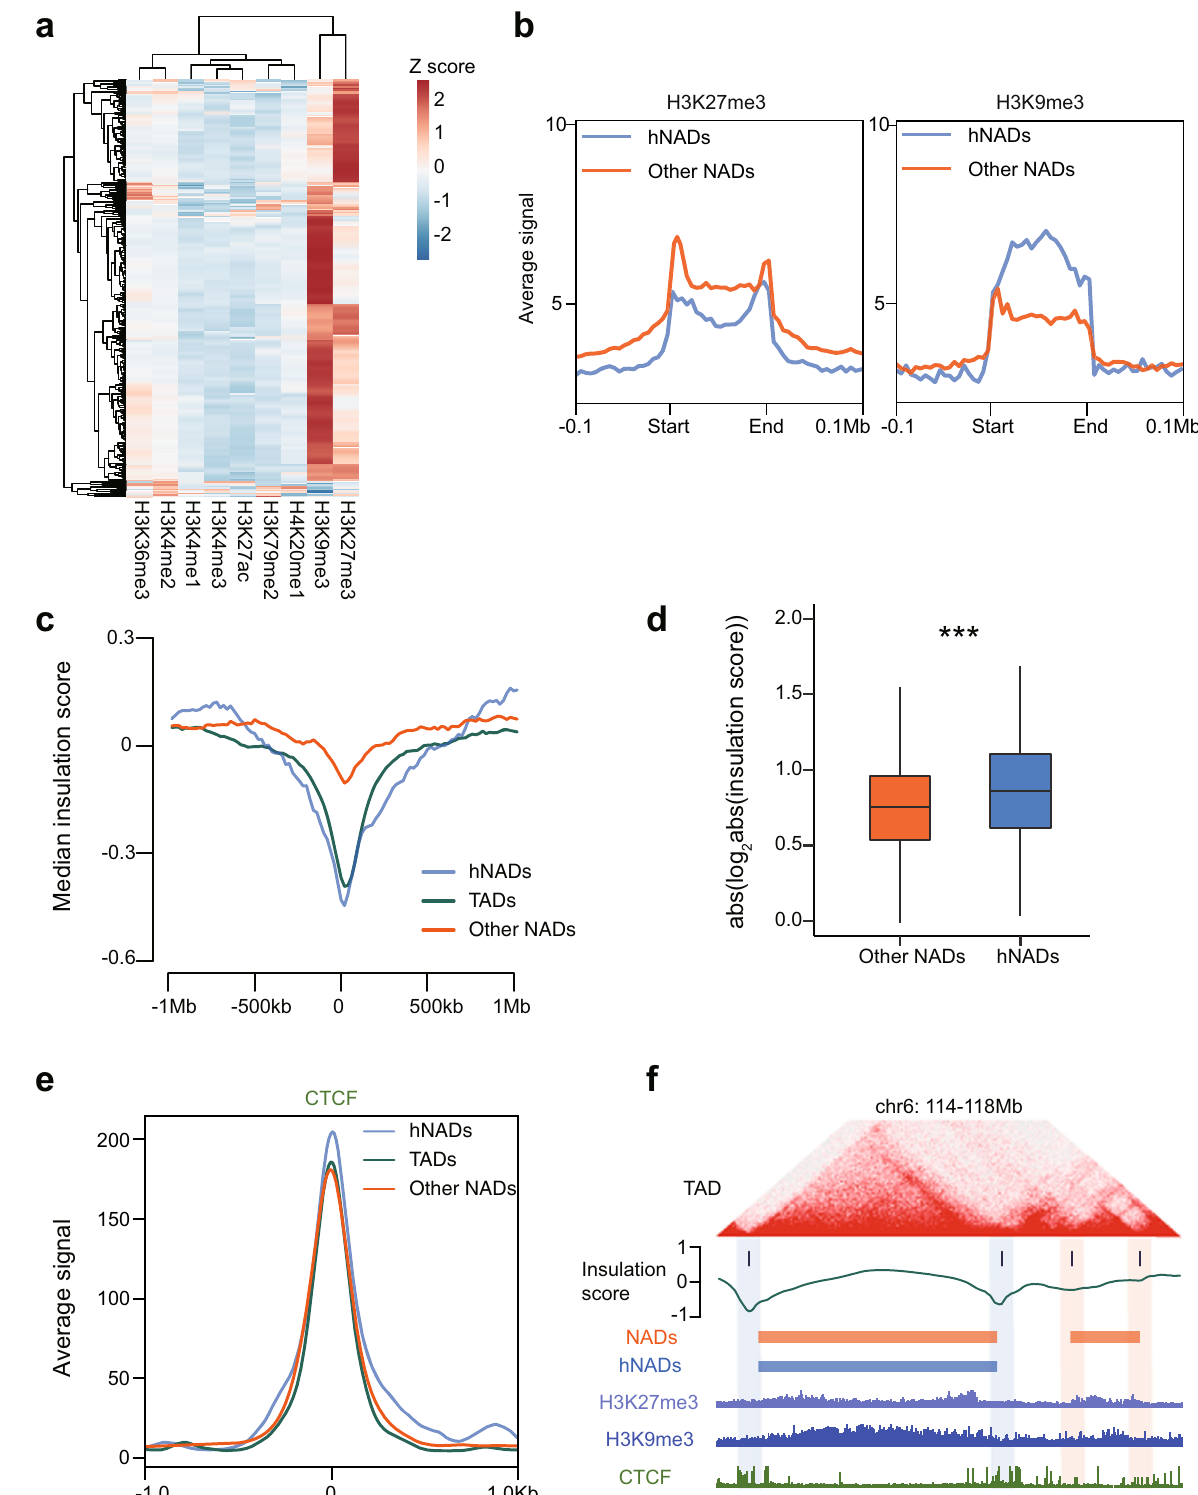
Fig. 6| ComparisonofepigeneticsignalsbetweenhNADsandTADs.a Heatmap of histone modi fi cation signals (columns) in hNAD regions (rows). b Aver- ageH3K27me3andH3K9me3signalsinhNAD,otherNADandsurroundingregions. c Median insulation scores surrounding the boundaries of NADs and TADs. d Box- plots (center line, median; box limits, the 25th and 75th percentiles) of insulation scores at hNADs and other NADs. n =588 TAD boundaries overlap with